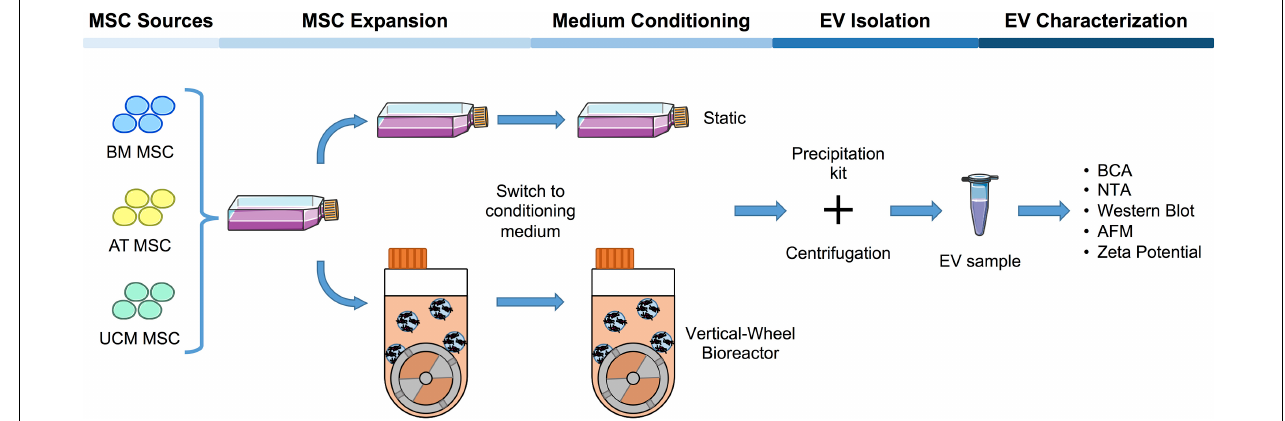
FIGURE 1 | Workflow of the production and characterization of MSC-EVs in bioreactors and static systems. MSC were isolated from three different human tissue sources: BM, AT, and UCM. Firstly, MSC were expanded in static conditions (i.e., T-flasks) in hPL supplemented DMEM. These cells were subsequently used to inoculate a VWBR (5M cells; 100 mL final working volume), as well as to maintain a static culture in T-175 flasks. For each cell source, MSC from three independent donors ( n = 3; BM1, 2, 3; AT1, 2, 3; UCM1, 2, 3) were used to inoculate either the final T-flasks for EV production or the VWBR, in passages from P4 to P5 [specifically, BM1 (P4); BM2 (P5); BM3 (P4); AT1 (P4); AT2 (P4); AT3 (P5); UCM1 (P4); UCM2 (P4); UCM3 (P5)]. Upon reaching stationary growth phase in VWBR or maximum confluency in static, the culture medium was changed for supplement-free culture medium and culture was maintained for 48 h. Over this period, culture medium was enriched in EVs secreted by cultured MSC. This conditioned culture medium was recovered and EVs were isolated by precipitation using a commercially available kit. Finally, EV production was quantified in both static and dynamic systems and samples were characterized using multiple techniques. MSC, mesenchymal stromal cells; EV, extracellular vesicles; VWBR, Vertical-WheelTM bioreactor; hPL, human platelet lysate; BM, bone marrow; AT, adipose tissue; UCM, umbilical cord matrix; NTA, nanoparticle tracking analysis; AFM, atomic force microscopy. The cells, T-flask and Eppendorf cartoons were obtained from Smart Servier Medical Art